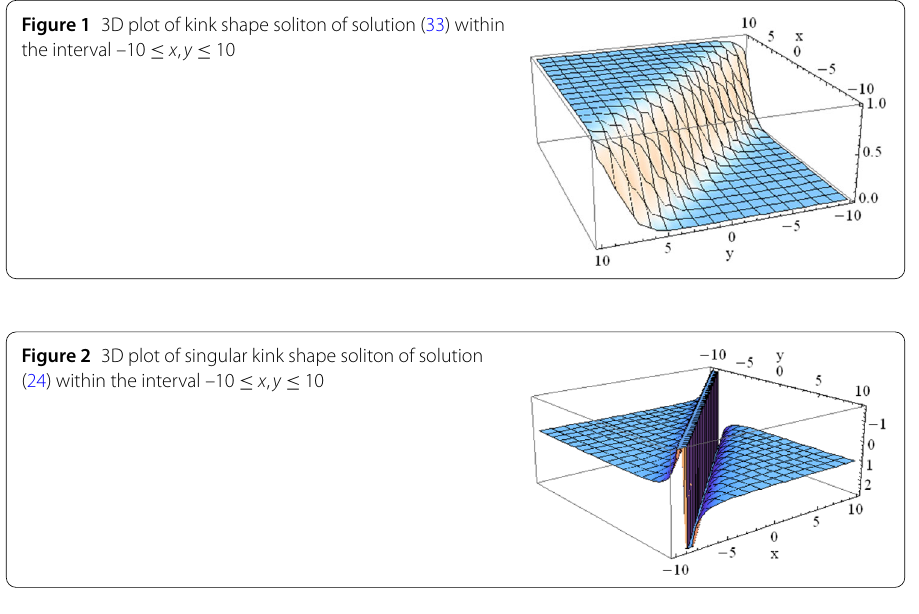
Figure 3 3D modulus plot of solution (27) which is anti-bell shape soliton within the interval –10 ≤ x , y ≤ 10